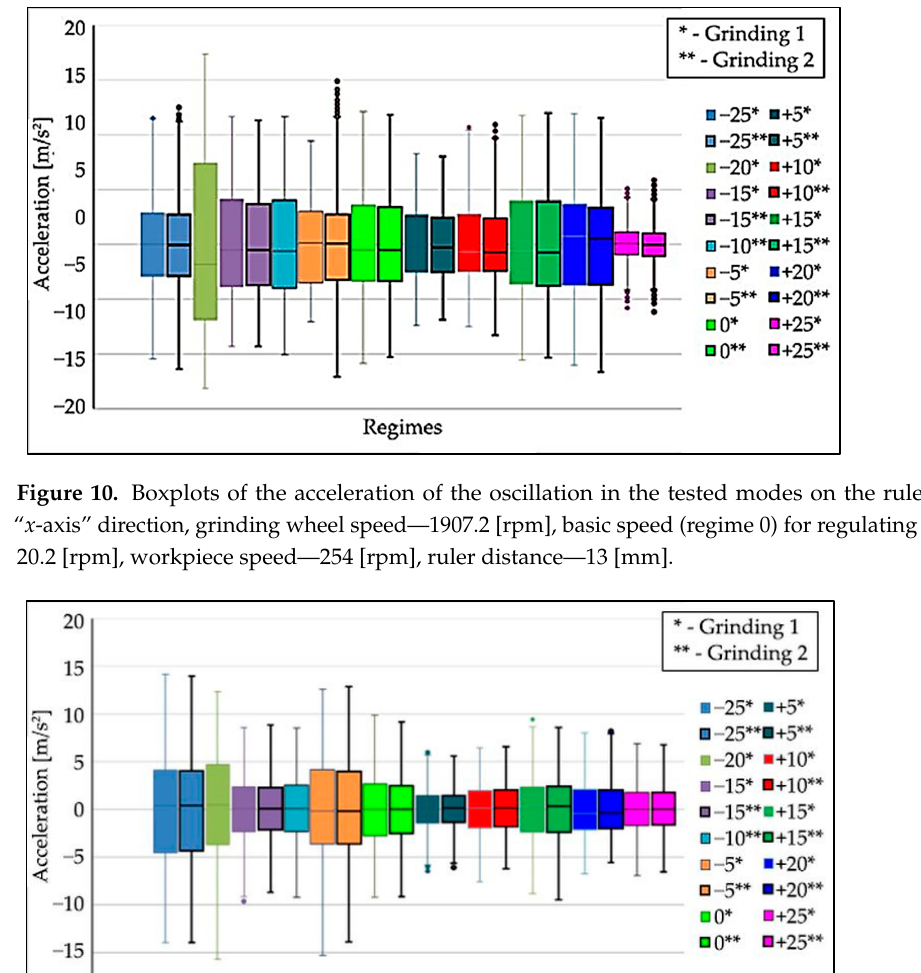
Table 5. Color coding of the different grinding modes.